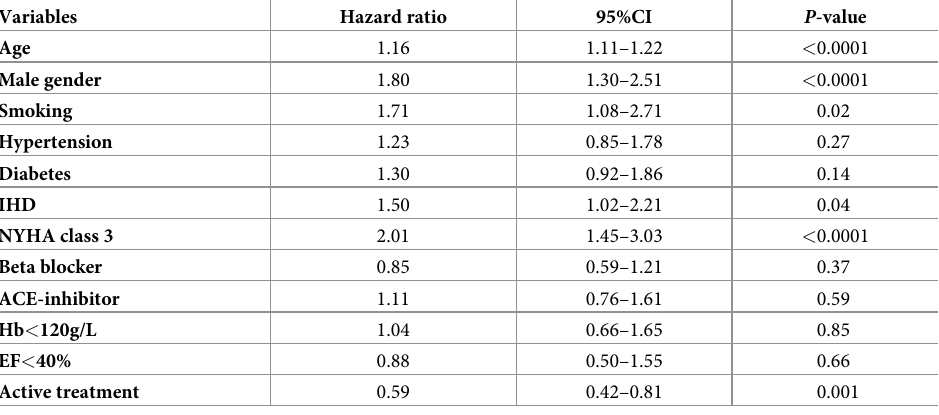
Table 2. Cox proportional hazard regression analysis evaluating risk of cardiovascular mortality by supplementa- tion of selenium and coenzyme Q10 combined in a multivariate model after 12 years of follow-up after 4 years of intervention to an elderly community